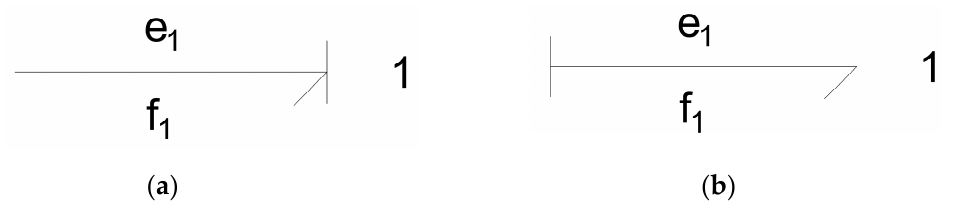
Figure 2. Causal stroke at a bond. (a) The causal stroke is near 1-junction. (b) The causal stroke is away from 1-jection.